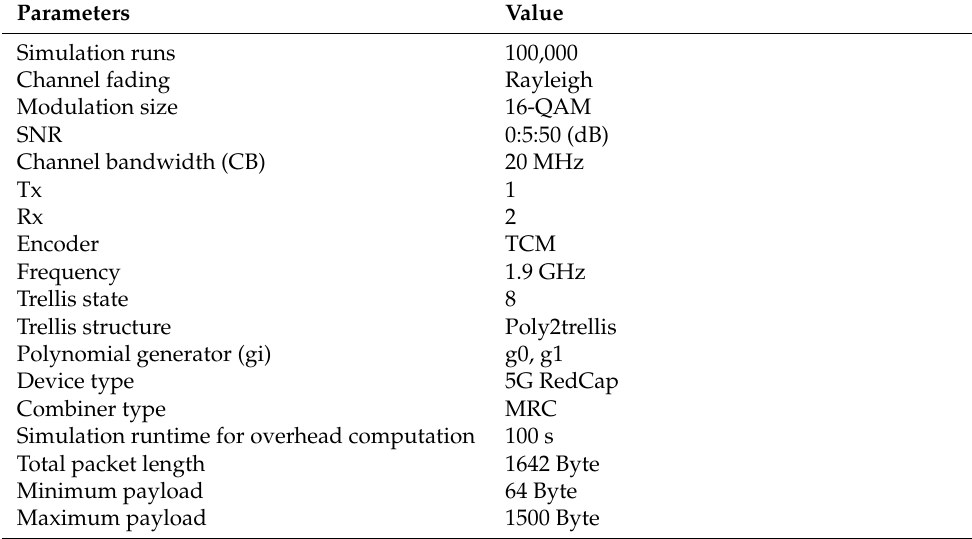
Table 2. Simulation